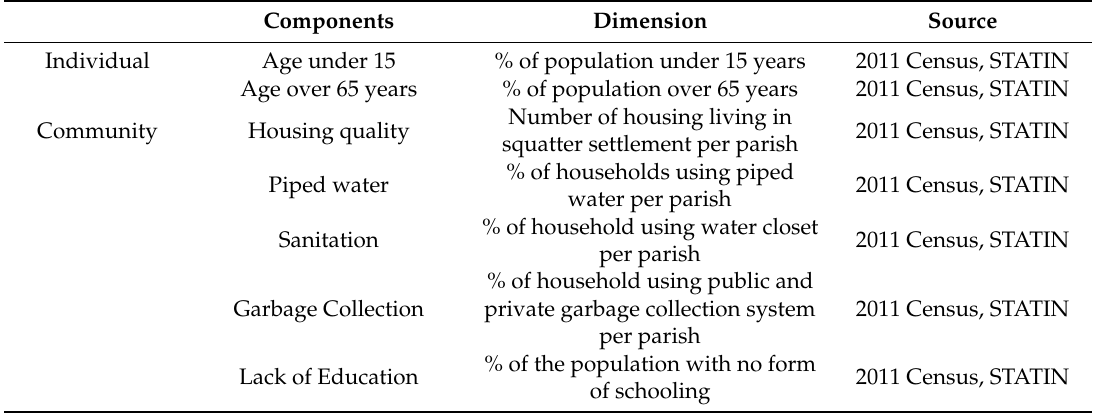
Table 2. Susceptibility indicator used for the WADI